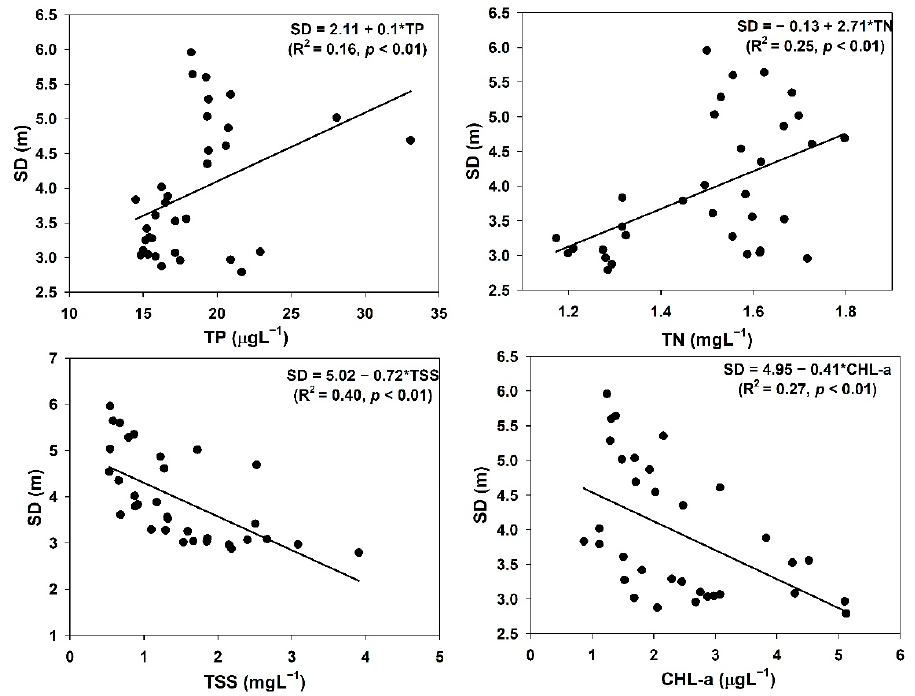
Figure 8. Relationships of water clarity (SD) with nutrients (TP: total phosphorus; TN: total nitrogen), total suspended solids (TSS), and algal chlorophyll (Chl-a: chlorophyll-a).